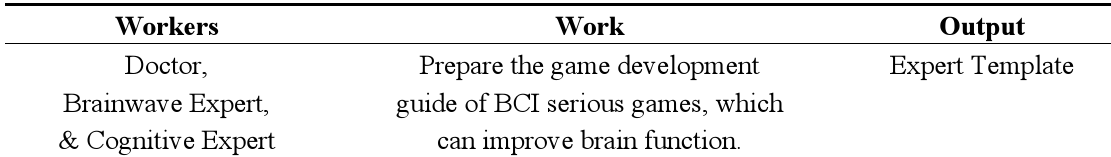
Table 1. Output from experts.